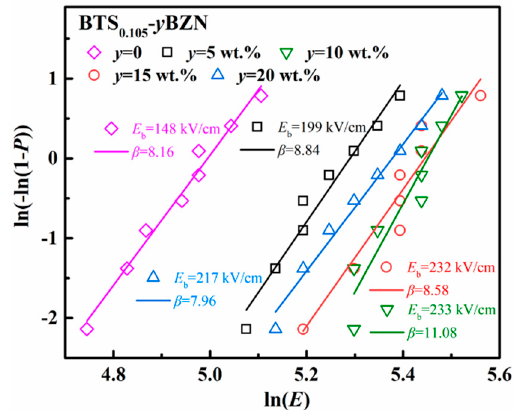
Figure 5. Weibull analysis for the BTS 0.105 − y BZN ceramics ( y = 5 wt %, 10 wt %, 15 wt %, 20 wt %) describing the electric strength for the materials.